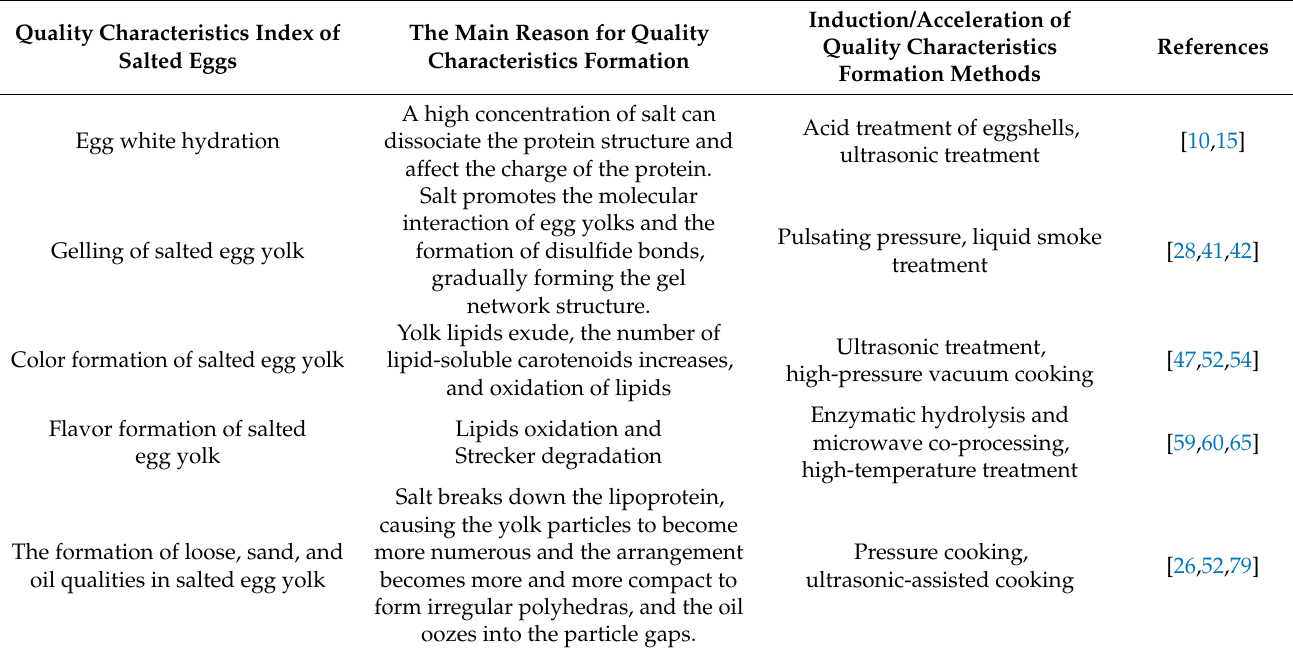
Table 1. The quality characteristics formation mechanism of salted